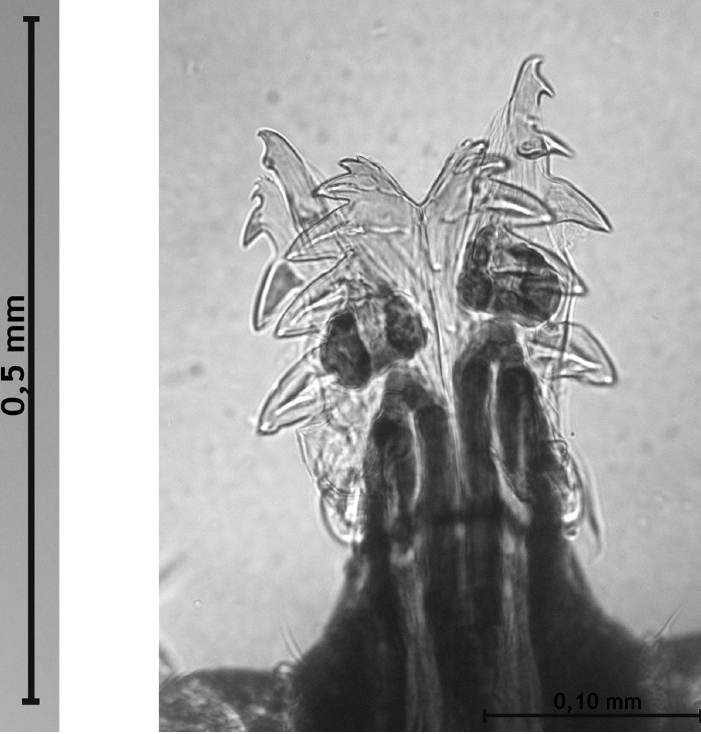
Fig. 8. – Hypostome of the male of Ixodes festai